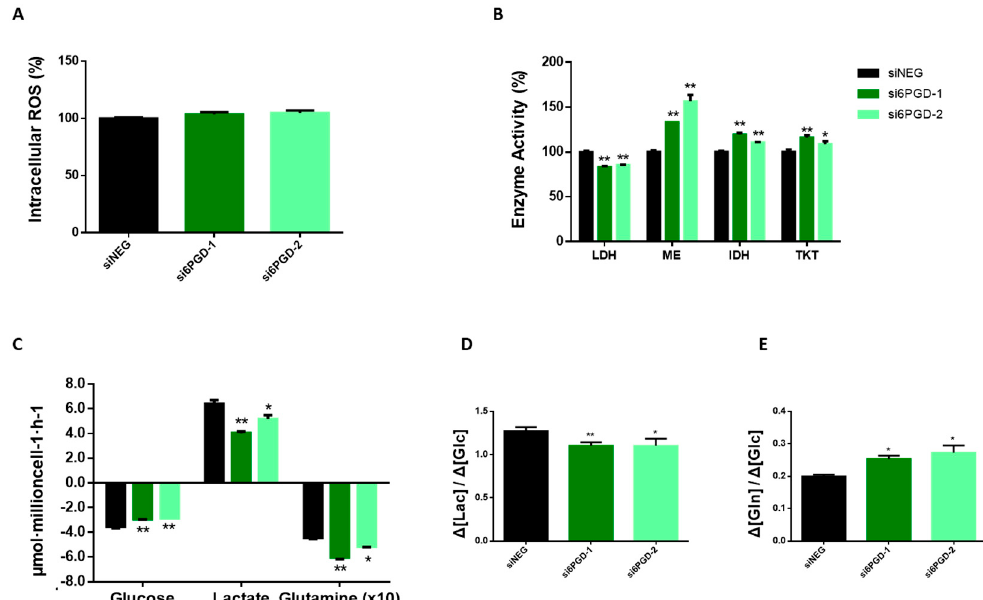
Figure 3. ( A ) Relative total intracellular reactive oxygen species (ROS) level measured by flow cytometry using H2DCFA probes. ROS levels are expressed as fold change with respect to siNEG ROS levels. ( B ) Lactate dehydrogenase, malic enzyme, isocitrate dehydrogenase, and transketolase activity levels measured at 96 h post-transfection using either siRNAs against 6PGD or non-targeting siRNA. Fold changes were calculated as a percentage relative to enzyme activity levels per mg of protein in siNEG-transfected cells. ( C ) Glucose and glutamine consumption and lactate production rates were measured 96 h after transfection by either si6PGD or siNEG. ( D ) Glycolytic activity showing the conversion rate of glucose to lactate. ( E ) Consumption rate of glutamine over glucose. One asterisk (*) denotes p -value < 0.05, two asterisks (**) denote p -value < 0.01.